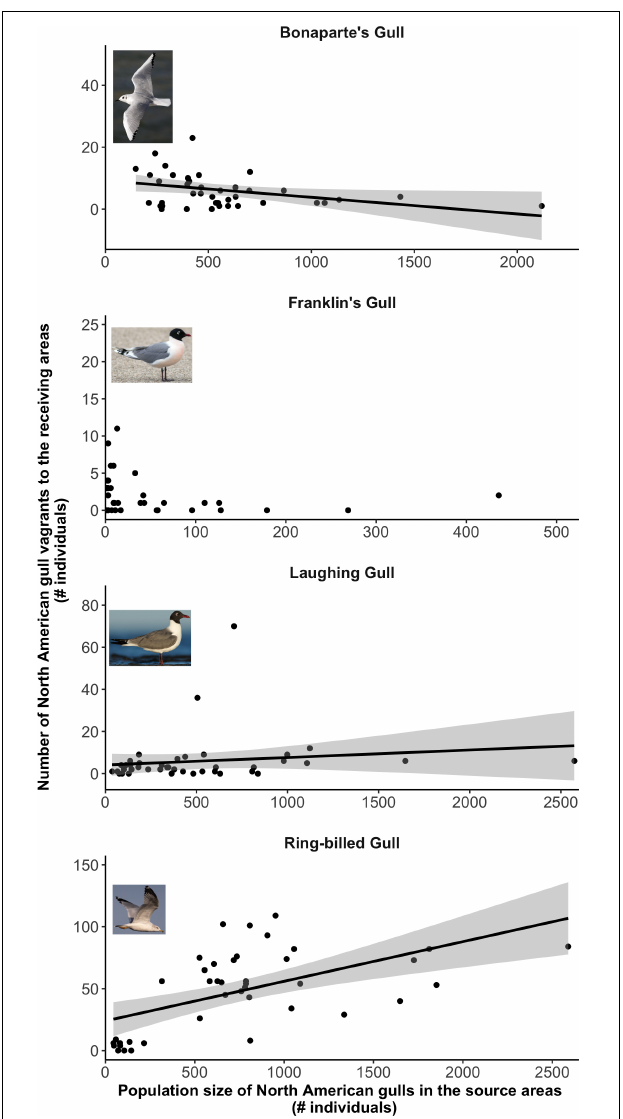
FIGURE 5 | Relationship between the number of North American gull vagrants reported in the European receiving areas in a given year and the size of their population of origin in the previous year. Only Franklin’s Gull did not show a statistically significant relationship between these two variables. Note that both axes have different scales.